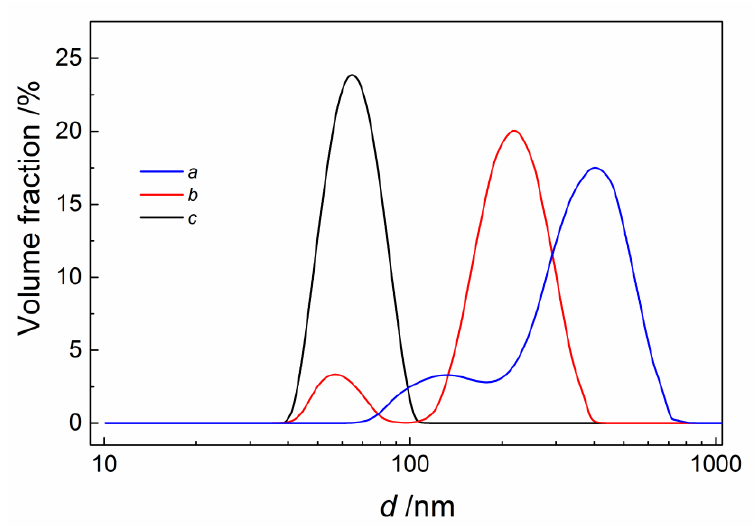
Figure 2. Volume fraction of particles with size d for sonication times t us of ( a ) 10 min, ( b ) 15 min, and ( c ) 60 min.